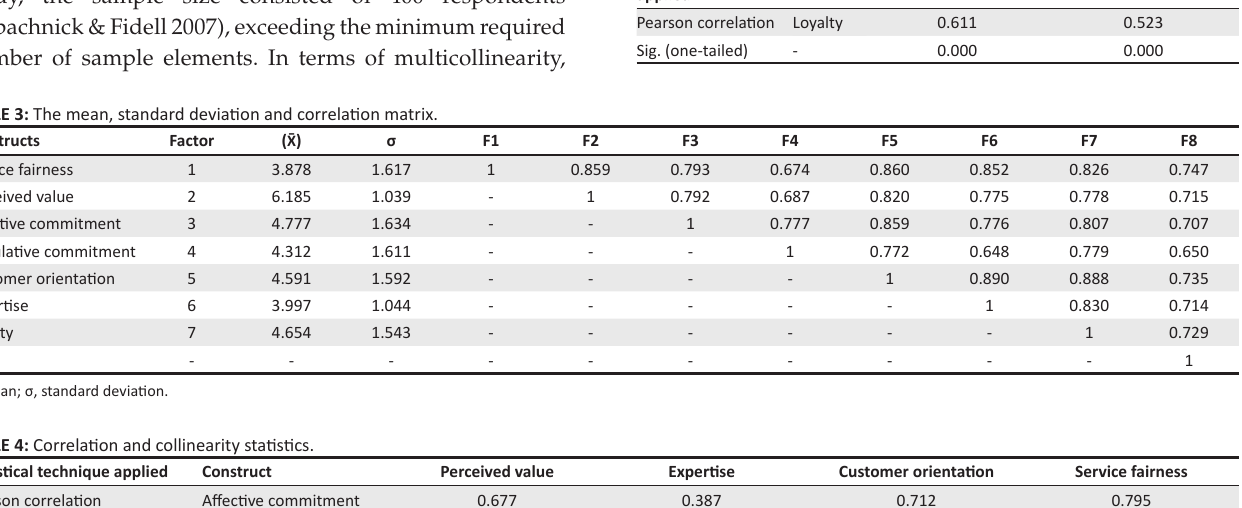
Pearson correlation